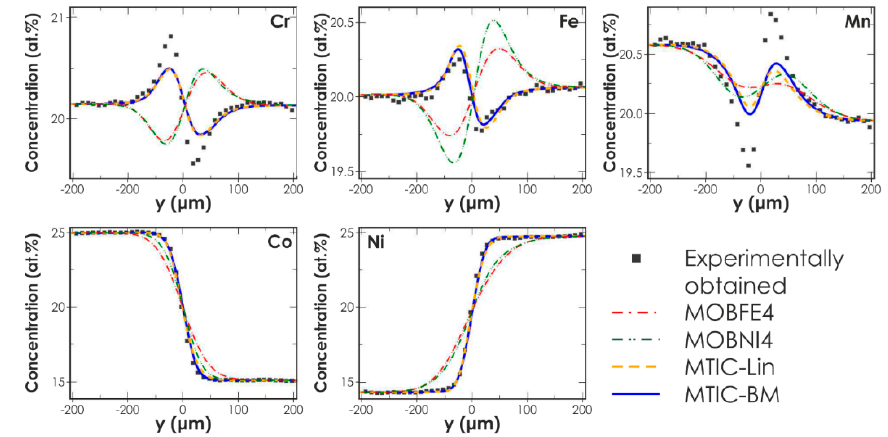
Figure 24. Composition-dependent atomic mobilities for Co, Cr, Fe, Mn, and Ni. Cr, Fe, and Mn concentration were assumed to be constant (20 at. % each). The black squares are the values determined from the experiments in constant composition, and a linear interpolation between the endpoints is shown as a solid line (MTIC-Lin). MTIC-BM (blue crosses) represents the result of the modified tracer-interdi ff usion couple (after [43]). Reprinted from Acta Materialia 166 (2019), Concentration-dependent atomic mobilities in FCC CoCrFeMnNi high-entropy alloys, 357–370, Copyright 2019, with permission from Elsevier.